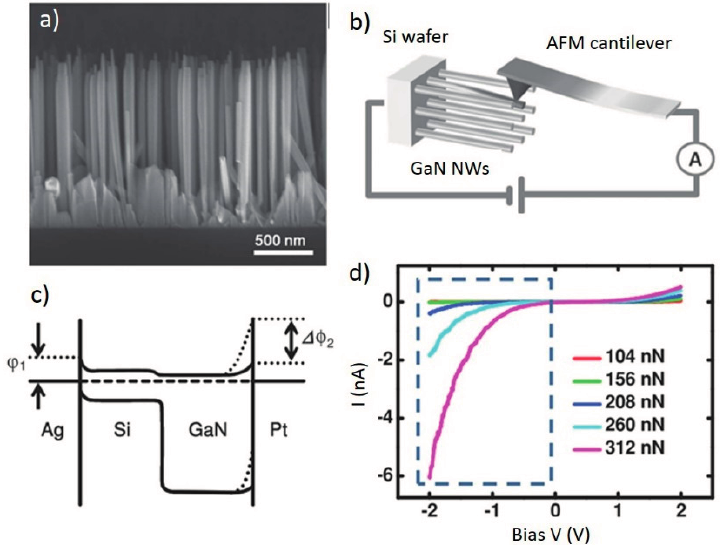
Figure 5. ( a ) SEM side view of vertical GaN nanowires; ( b ) Device testing schematic; ( c ) Band diagram of Ag-Si/GaN-Pt metal-semiconductor-metal architecture; ( d ) Current-voltage characteristics measured against applied force. Adapted by permission from John Wiley and Sons: Advanced Materials [66] Copyright